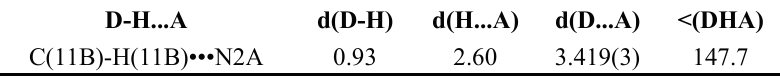
Table 3. Hydrogen-bond parameters ( Ǻ ) of the title compound.